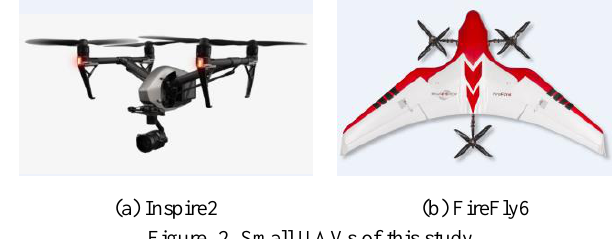
Figure. 2. Small UAVs of this study